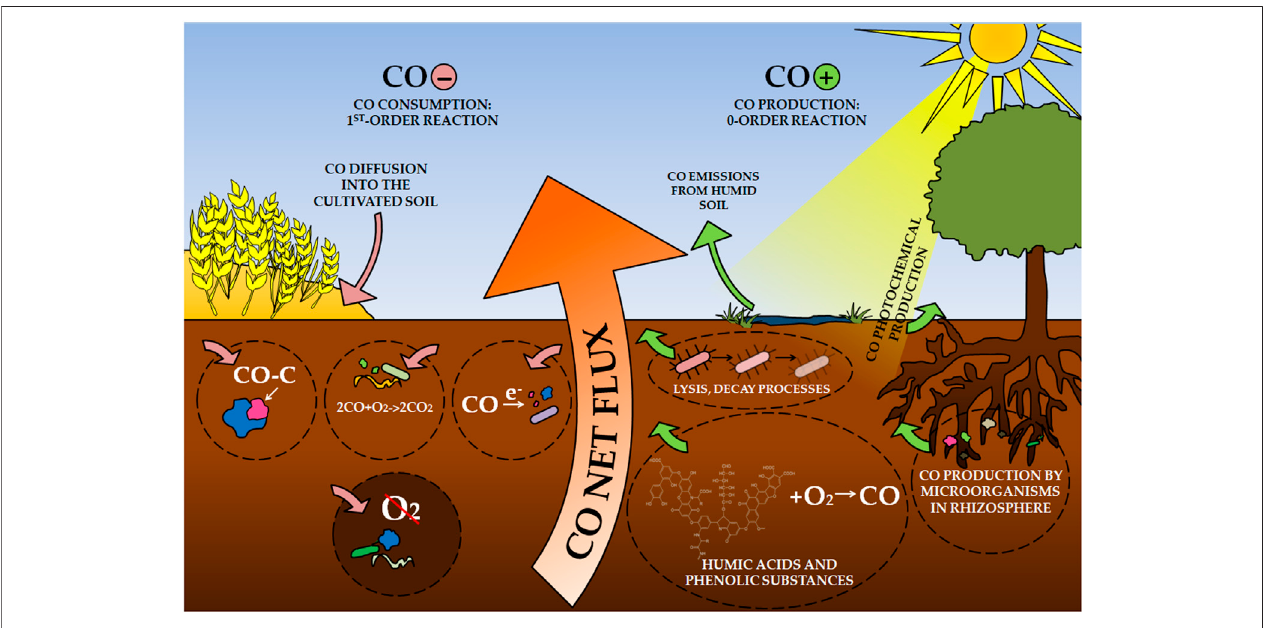
FIGURE 1 | Carbon monoxide cycle in